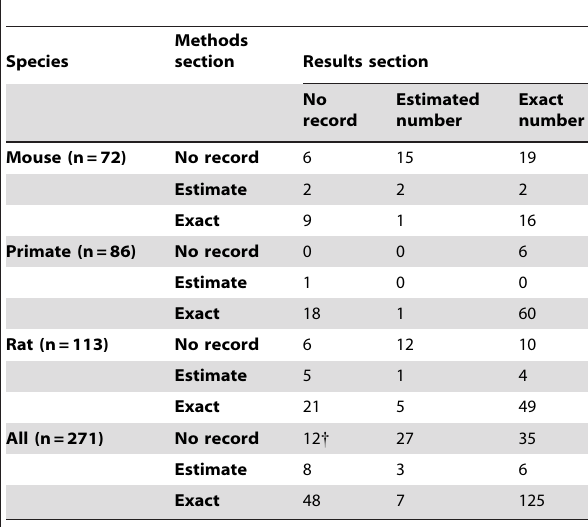
Table 9. Number of studies reporting animal numbers in the methods and results